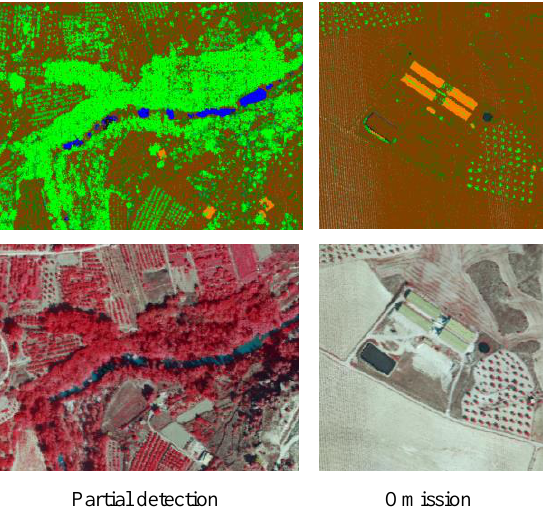
Figure 6 – Examples of water detection situations (in blue) Analysing the water results we can say that: Commission errors correspond with two shadows in flat